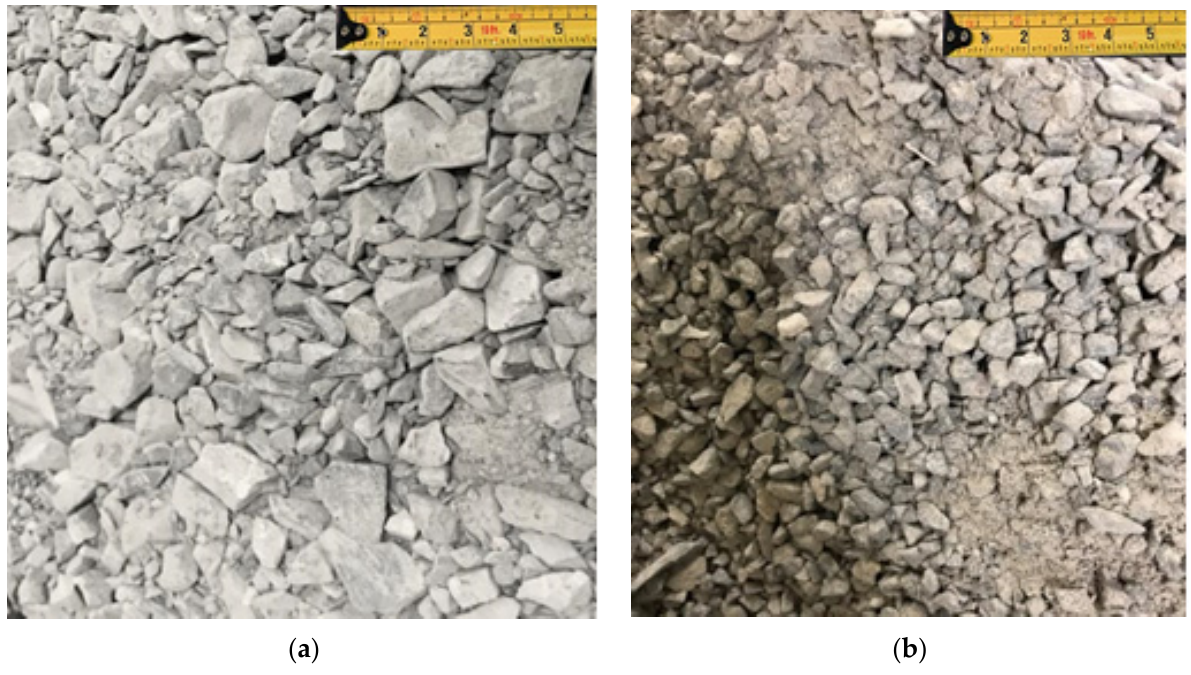
Figure 3. Photos of original ( a ) WR 1 and ( b ) WR 2.